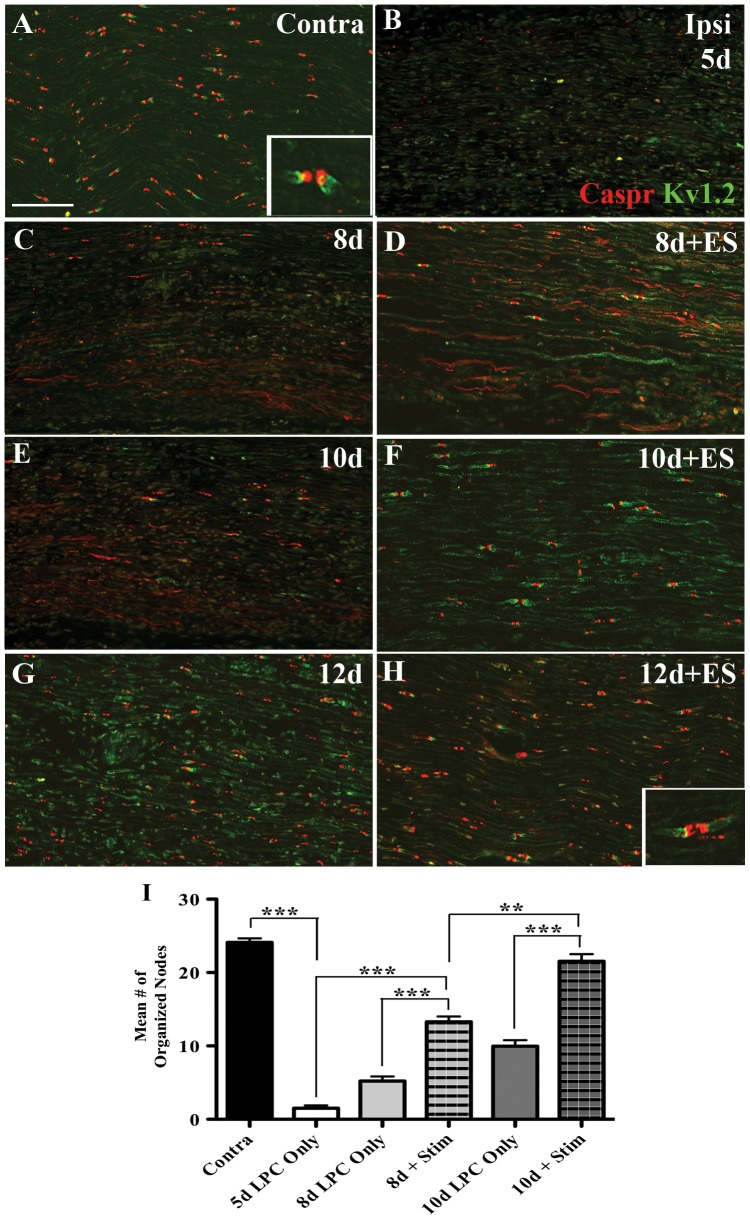
Accelerated node of Ranvier reorganization in focally demyelinated nerves subjected to 1hr ES.Representative photomicrographs of FG-positive (i.e focally demyelinated) regions of longitudinal tibial nerve sections dually immunostained for the paranodal protein Caspr (red) and the juxtaparanodal Kv1.2 ion channel (green). Contralateral control nerves display well-organized nodes of Ranvier with Caspr IF in the paranodal region and Kv1.2 IF at the juxtaparanodal region (A, insert reveals nodal staining at higher magnification) and an average of 24.1 visible nodes per field of view as defined by a 1300×900 pixel rectangle superimposed on the photomicrograph (I). A marked loss of nodal organization was observed 5d post-lysophosphatidyl choline (LPC)/FG injection, with an average of 1.5 nodal regions per field of view (B, I). Temporal analysis of LPC +/- ES delivered 5 d post-LPC and indicated in days post-LPC: 8d (C), 8d+ES (D), 10d (E), 10d+ES (F) and 12d (G) 12d+ES (H) post-LPC, revealed that ES delivered 5 d post_LPC resulted in nodal reorganization apparent as early as 8d post-LPC (8d+ES - 3d post-ES; D), with a mean of 13.28 nodes per field of view, as compared to 5.19 in the non-stimulated nerves (8d post-LPC only; C, I). The reorganization continued at 10d post-LPC in the ES nerves, approaching contralateral control nerve levels (10d+ES - 5d post-ES; F), with a mean of 21.53 nodes per field of view in the stimulated nerves (I), compared to 9.96 in the non-stimulated (10d post-LPC; E, I) that did not discernibly change at the 12d post-LPC (12d+ES - 7d post-ES; H and insert). Tissue from the LPC only group displayed modest nodal re-organization (G)12d post-LPC consistent with the appearance of only faint remyelination (see Figure 2M). Scale bar  =  100 µm.